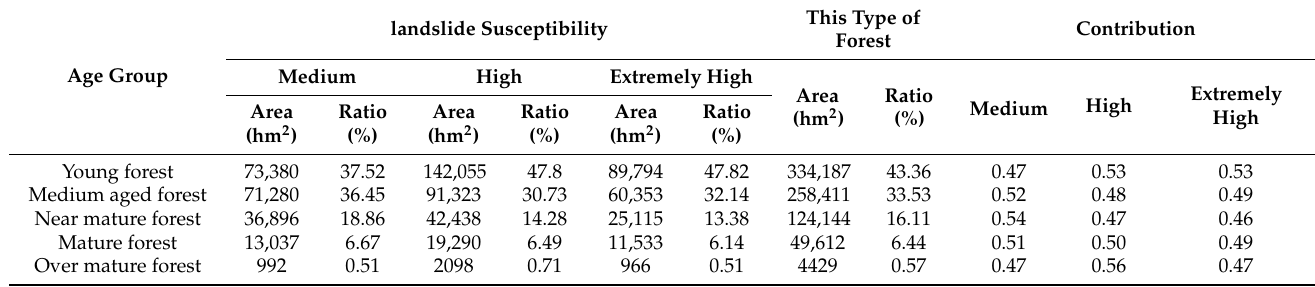
Table 3. Relationship between forest age groups and landslide susceptibility in Bijie City.